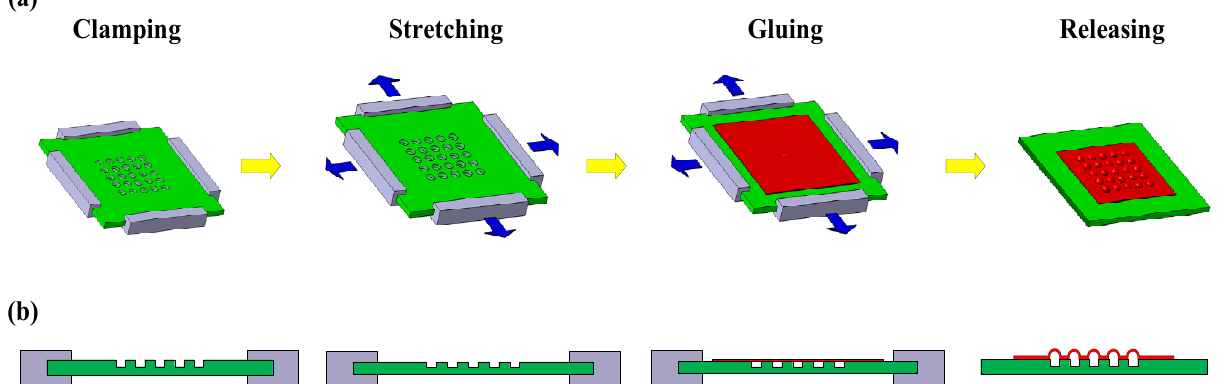
Figure 2. ( a ) Fabrication procedure of curved film microstructure array; ( b ) Forming process of film microstructures corresponding to fabrication steps.